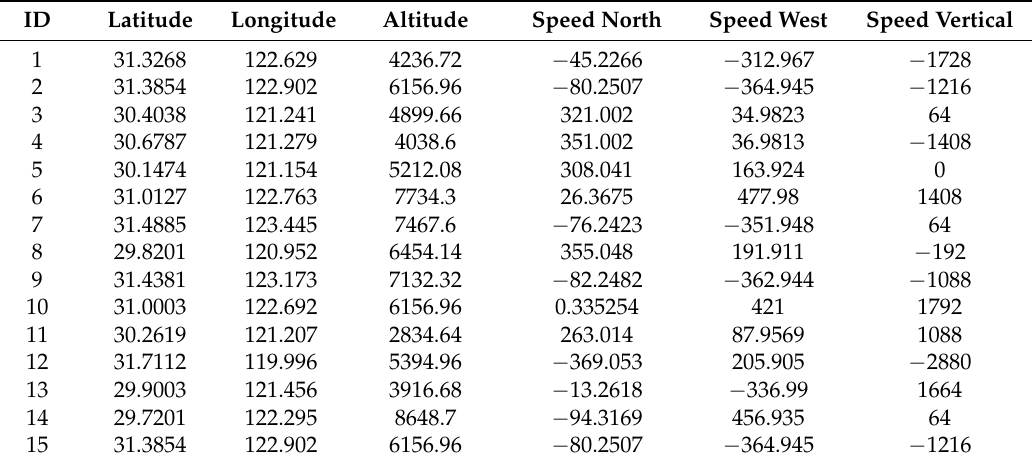
Table 3. Part of aircraft